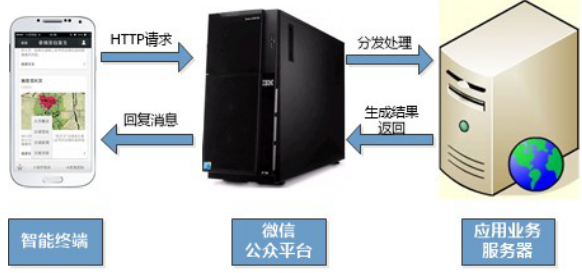
Figure 5. Mobile and Server